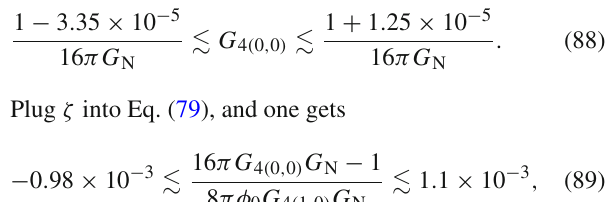
Table 1 Orbital parameters of the binary system PSR J1738+0333 [85] Eccentricity e ( 3 . 4 ± 1 . 1 ) × 10 − 7 Orbital period T (days) 0.354 790 739 8724(13) Period change ˙ T obs ( − 25 . 9 ± 3 . 2 ) × 10 − 15 Pulsar mass m 1 ( M (cid:14) ) 1 . 46 + 0 . 06 − 0 .